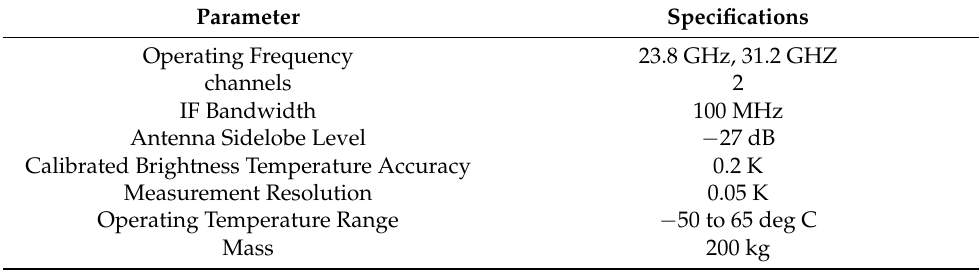
Table 1. Key radiometer specifications.